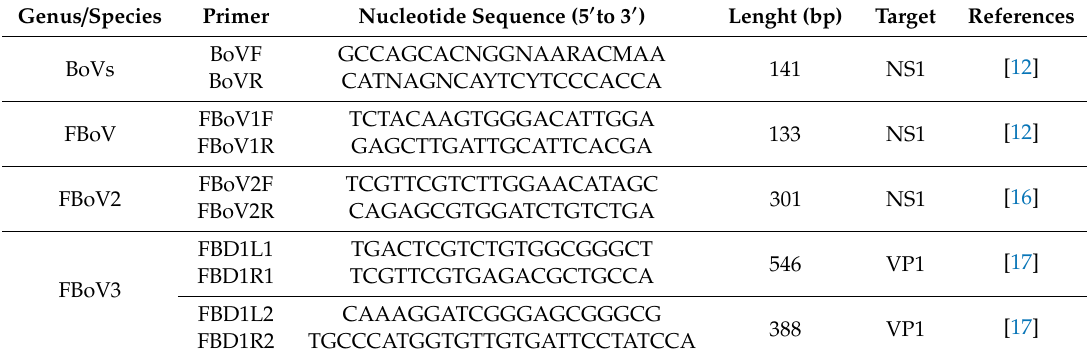
Table 5. List of consensus or specific primers used for the detection of